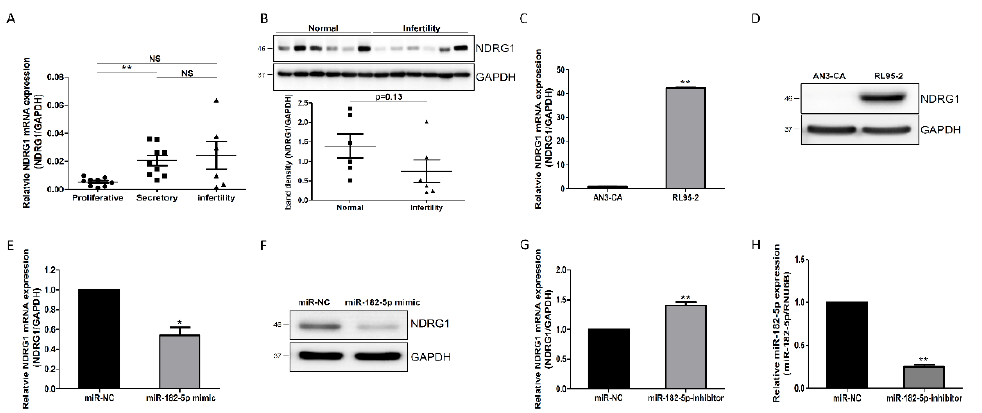
Figure 2. miR-182-5p negatively regulated NDRG1 expression in endometrial epithelial cells. ( A ) Analysis of NDRG1 mRNA expression in proliferative and secretory phases and in secretory phase infertile endometrial tissues. ( B ) Analysis of NDRG1 protein in normal and infertile endometrial tissues. ( C ) Analysis of NDRG1 mRNA expression in non-receptive AN3-CA and receptive RL95-2 cells. ( D ) Analysis of NDRG1 protein expression in AN3-CA and RL95-2 cells. ( E ) Effect of the miR-182-5p mimic on NDRG1 mRNA expression in RL95-2 cells. ( F ) Effect of the miR-182-5p mimic on NDRG1 protein expression in RL95-2 cells. ( G ) Effect of the miR-182-5p inhibitor on NDRG1 mRNA expression in AN3-CA cells. ( H ) Confirmation of miR-182-5p expression in AN3-CA cells transfected with the miR-182-5p inhibitor. The data shown represent the mean ± SEM from three independent experiments (n = 3). * p < 0.05, ** p < 0.01; NS: not significant.